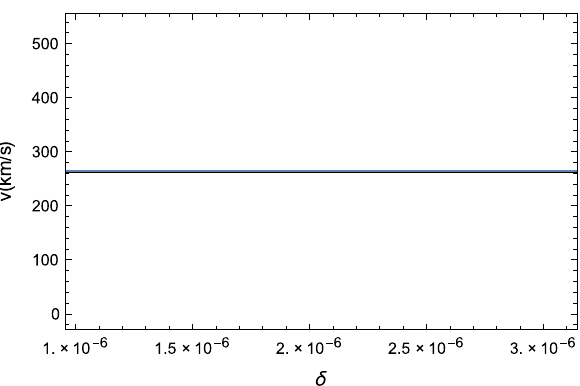
Fig. 2 The theoretical effective f ( R ) rotation velocity curve w.r.t. the > 1. It shows that the rotational model parameter δ << 1 with r 0 r velocity attains a constant value for different values of the parameter δ . The smaller value of δ seems to be consistent with the explanation of the effects of dark matter on the rotational velocity of the test mass in the outer regions of the galaxy